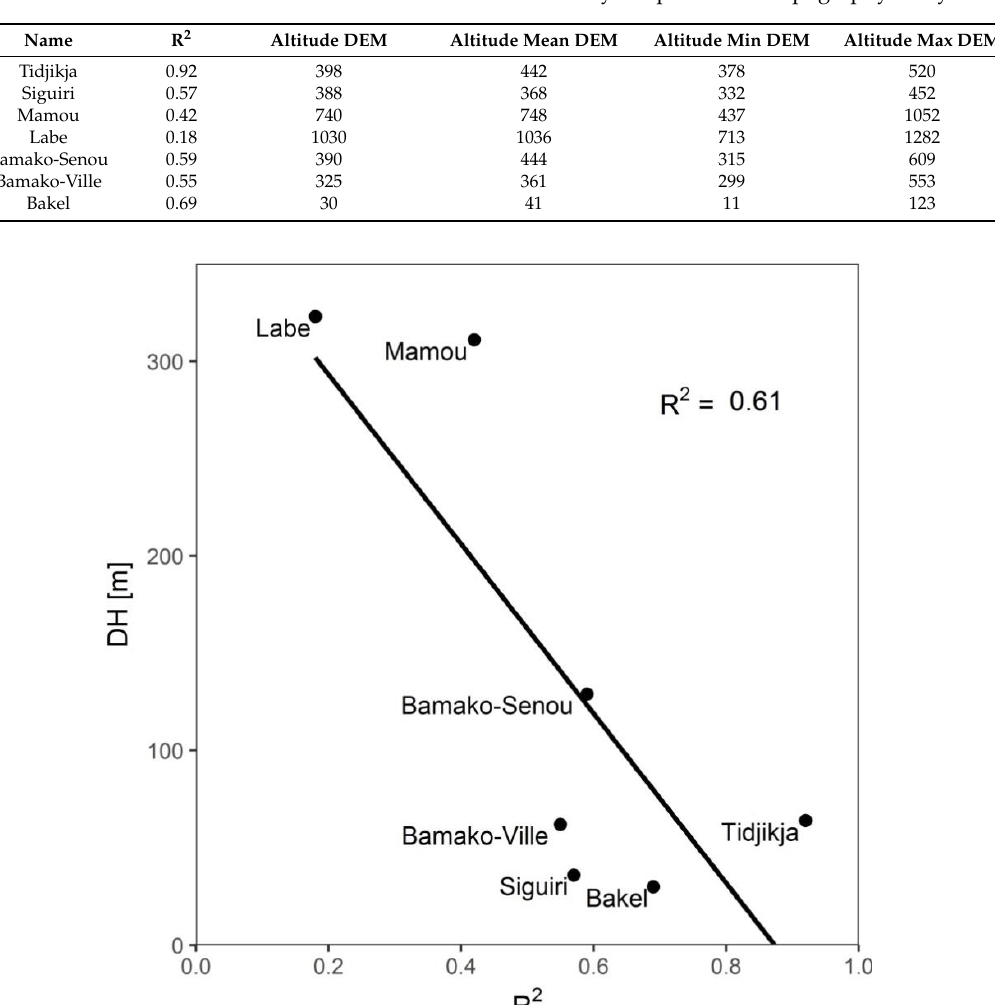
Table 3. Correlation between ERA-Interim and observed daily temperatures—topography analysis.